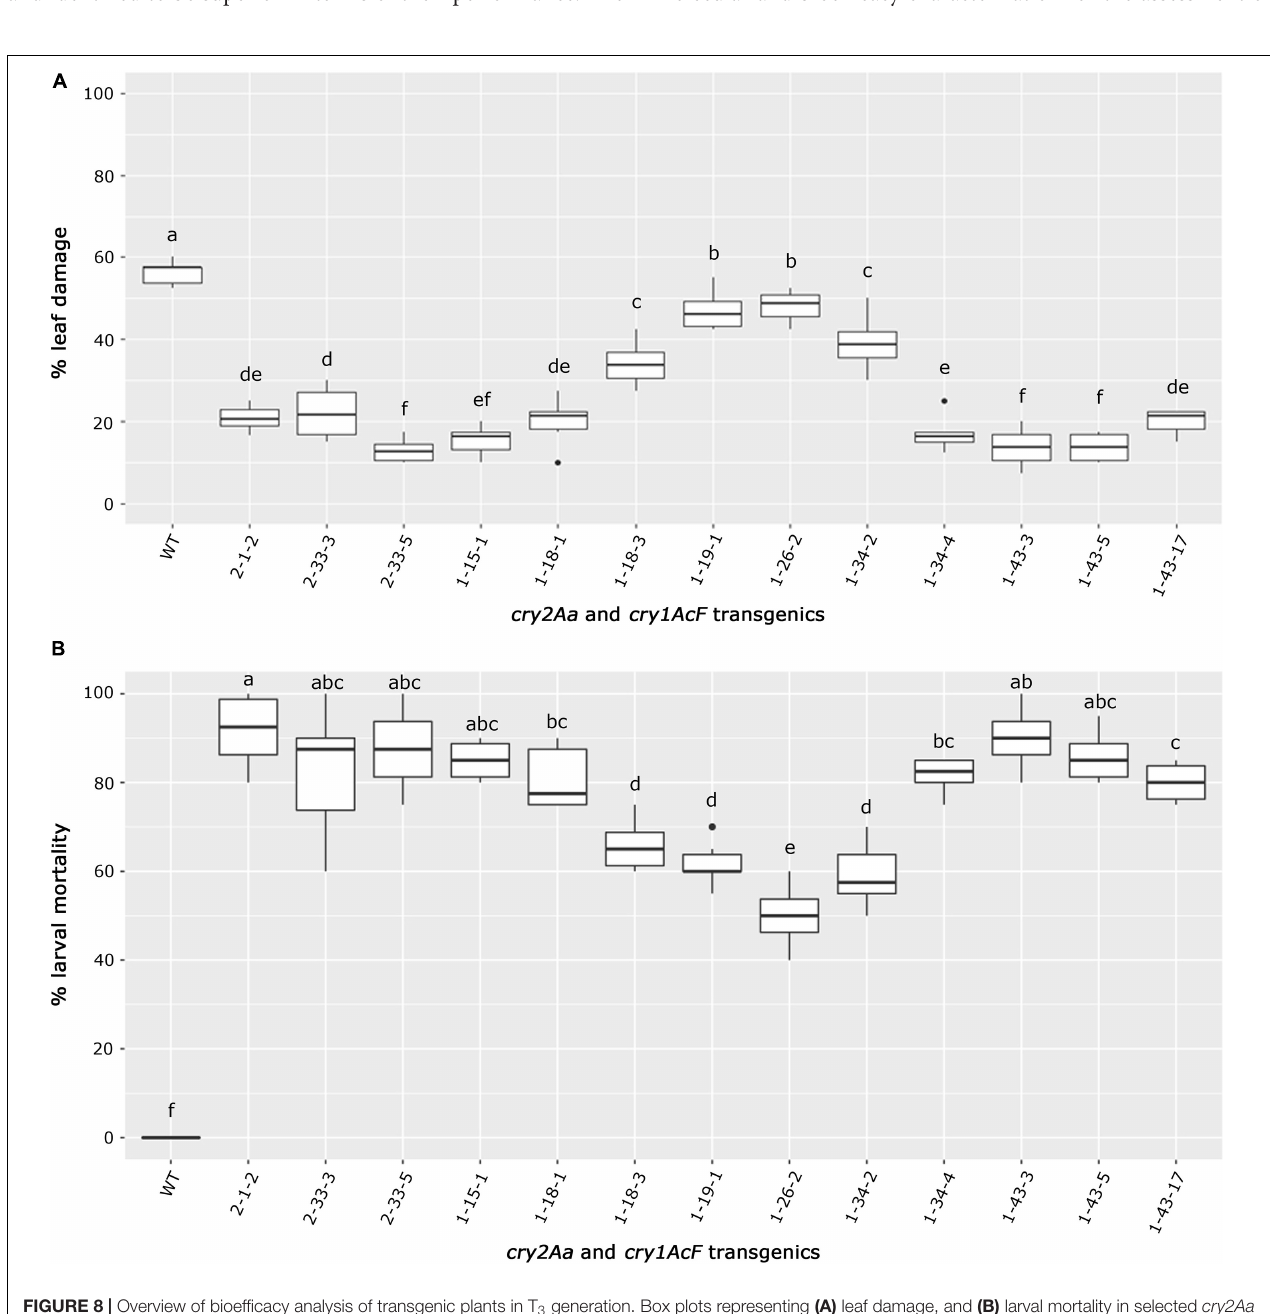
FIGURE 8 | Overview of bioefficacy analysis of transgenic plants in T 3 generation. Box plots representing (A) leaf damage, and (B) larval mortality in selected cry2Aa and cry1AcF events and their respective wild type plants. The significant differences among the transgenic events and wild types were analyzed by Tukey’s HSD test with p <